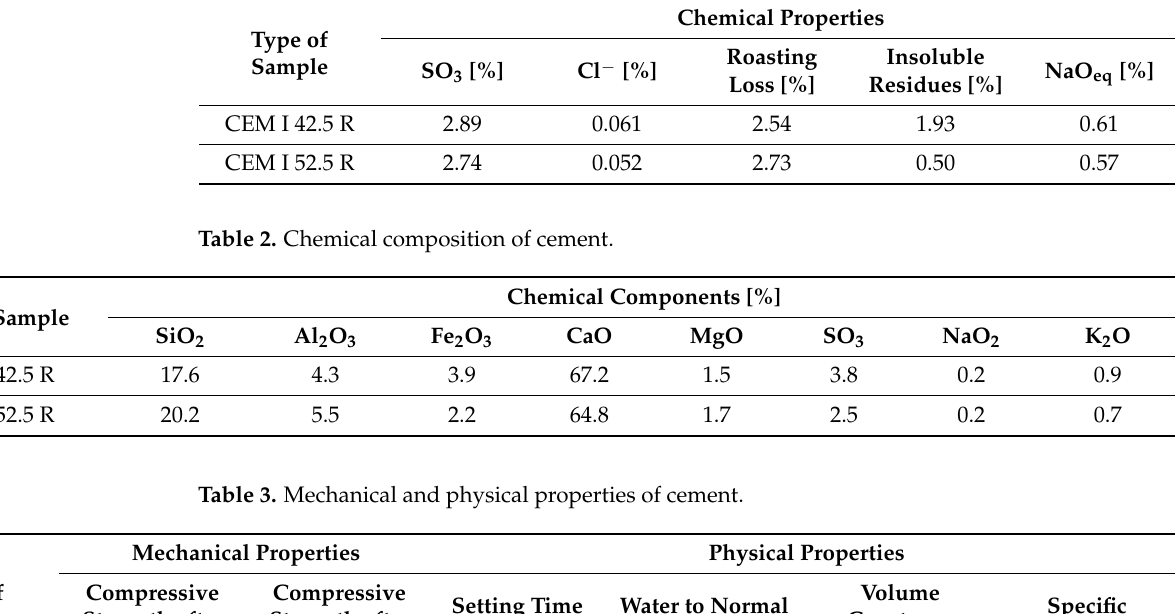
Table 1. Chemical properties of cement.